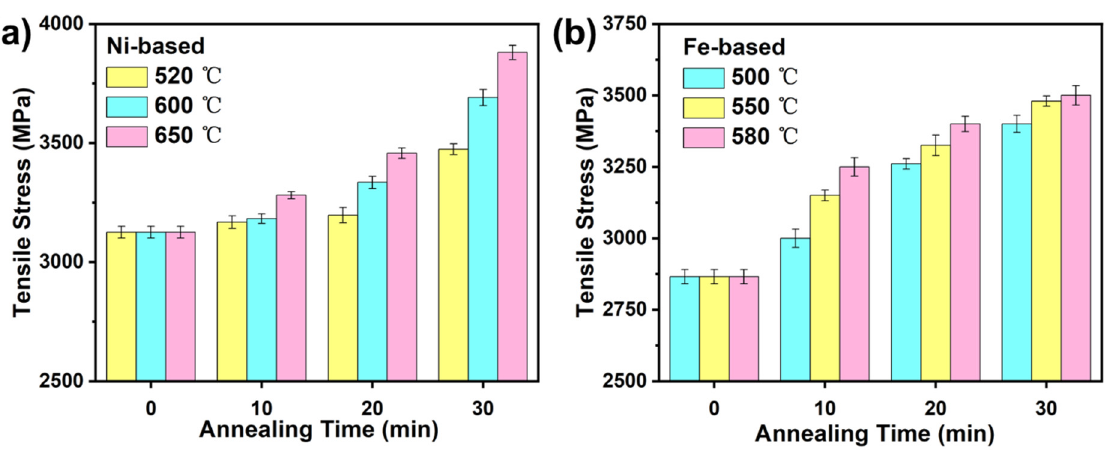
Figure 4. Fracture stress variation of AMFs before and after annealing. ( a ) Ni-based fibers. ( b ) Fe-based fibers.